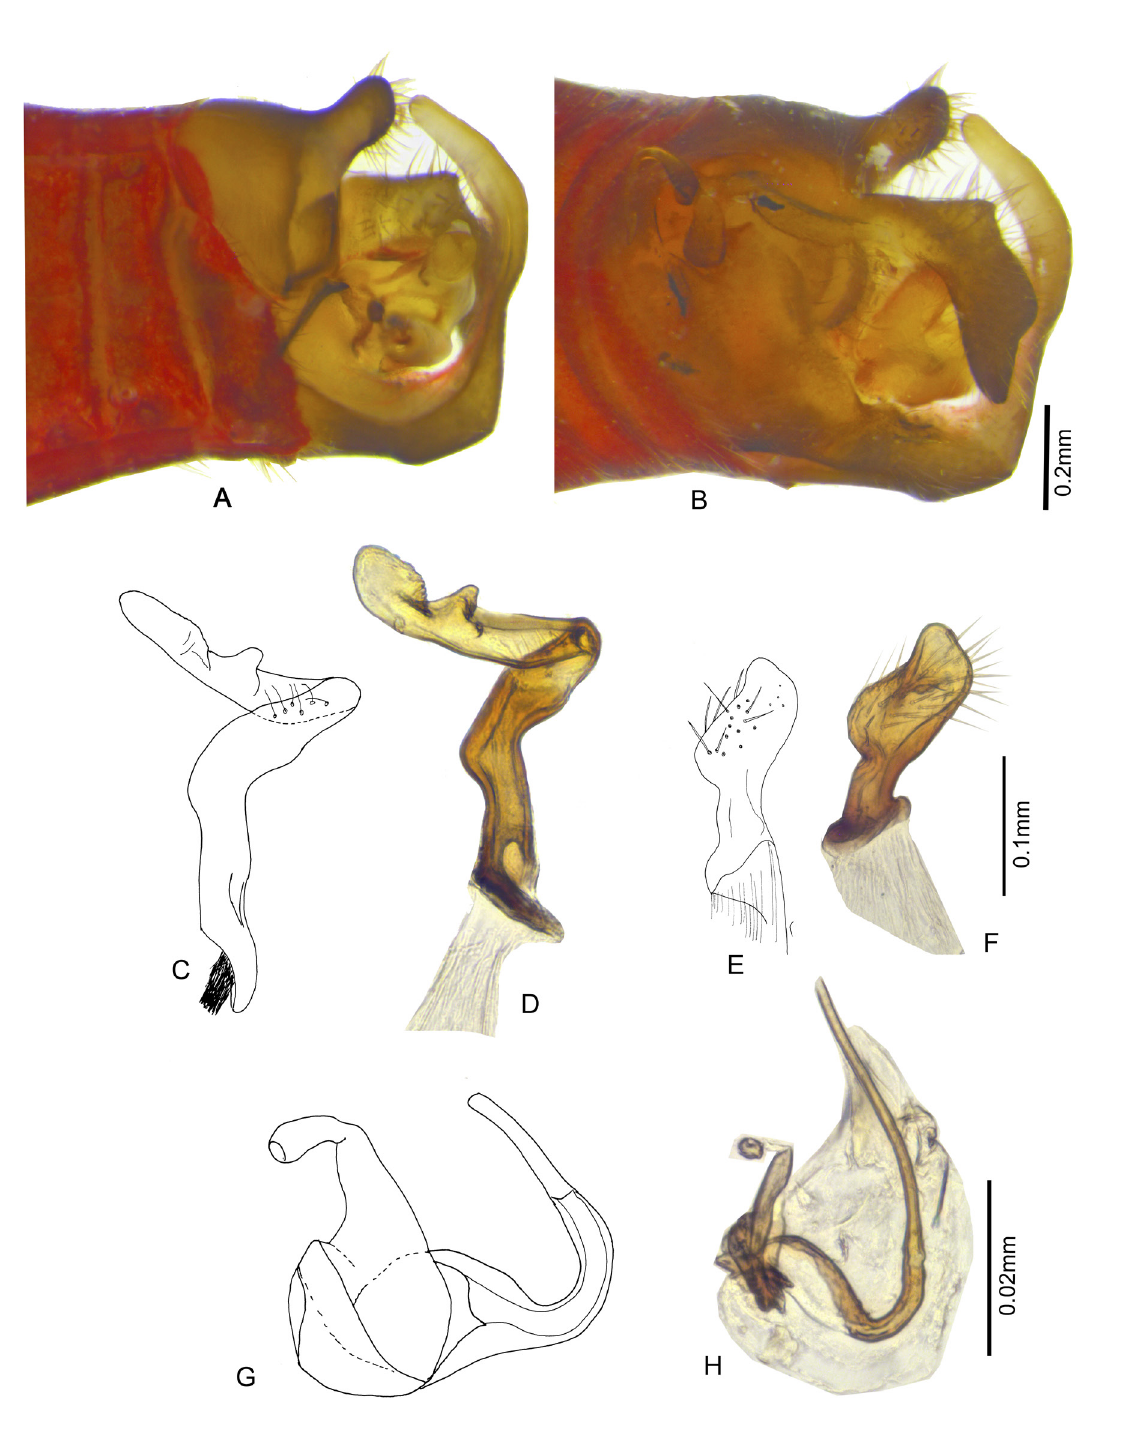
Fig. 15. Male genitalia of Harpedona sanguinipes Distant, 1904, UASB. A–B . Genital capsule in dorsal and ventral views. C–D . Left paramere in lateral view. E–F . Right paramere in dorsal view. G–H . Aedeagus in lateral